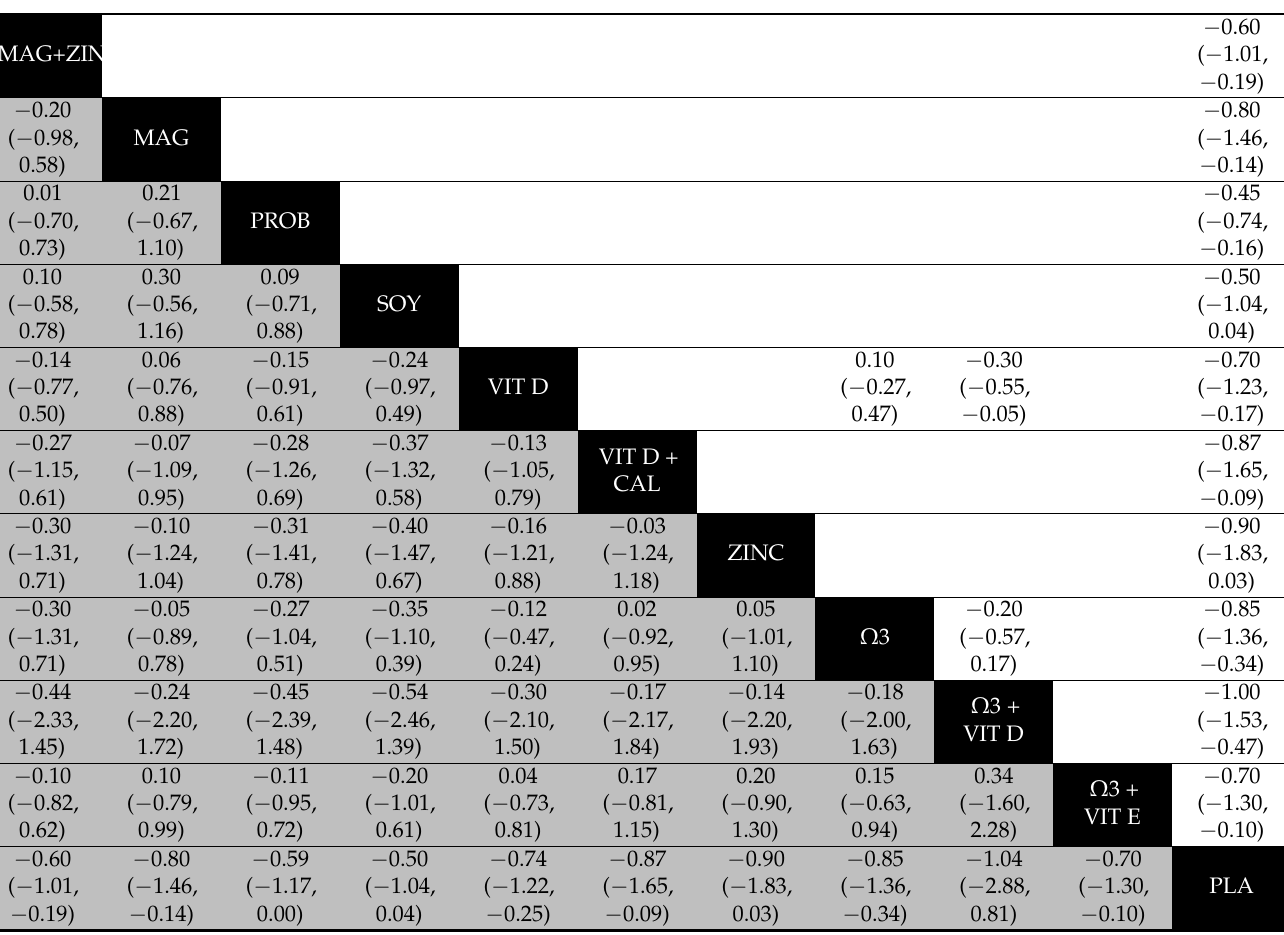
Table 4. Direct and indirect (in grey) estimates of the mean difference of ∆ MDA. Each column presents a different intervention.